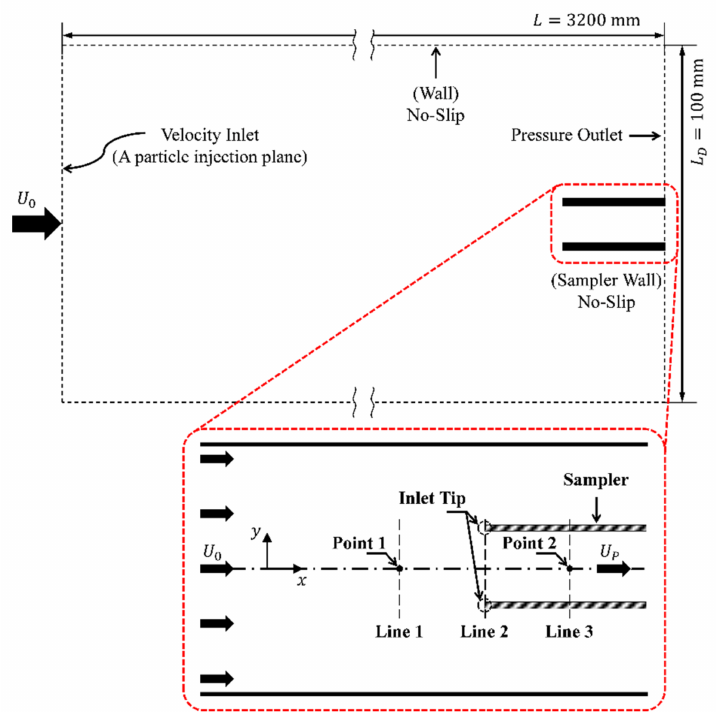
Figure 3. Simulation conditions: numerical analysis showing the domain and boundary conditions and inlet tip of sampling probe and velocity-distribution analysis